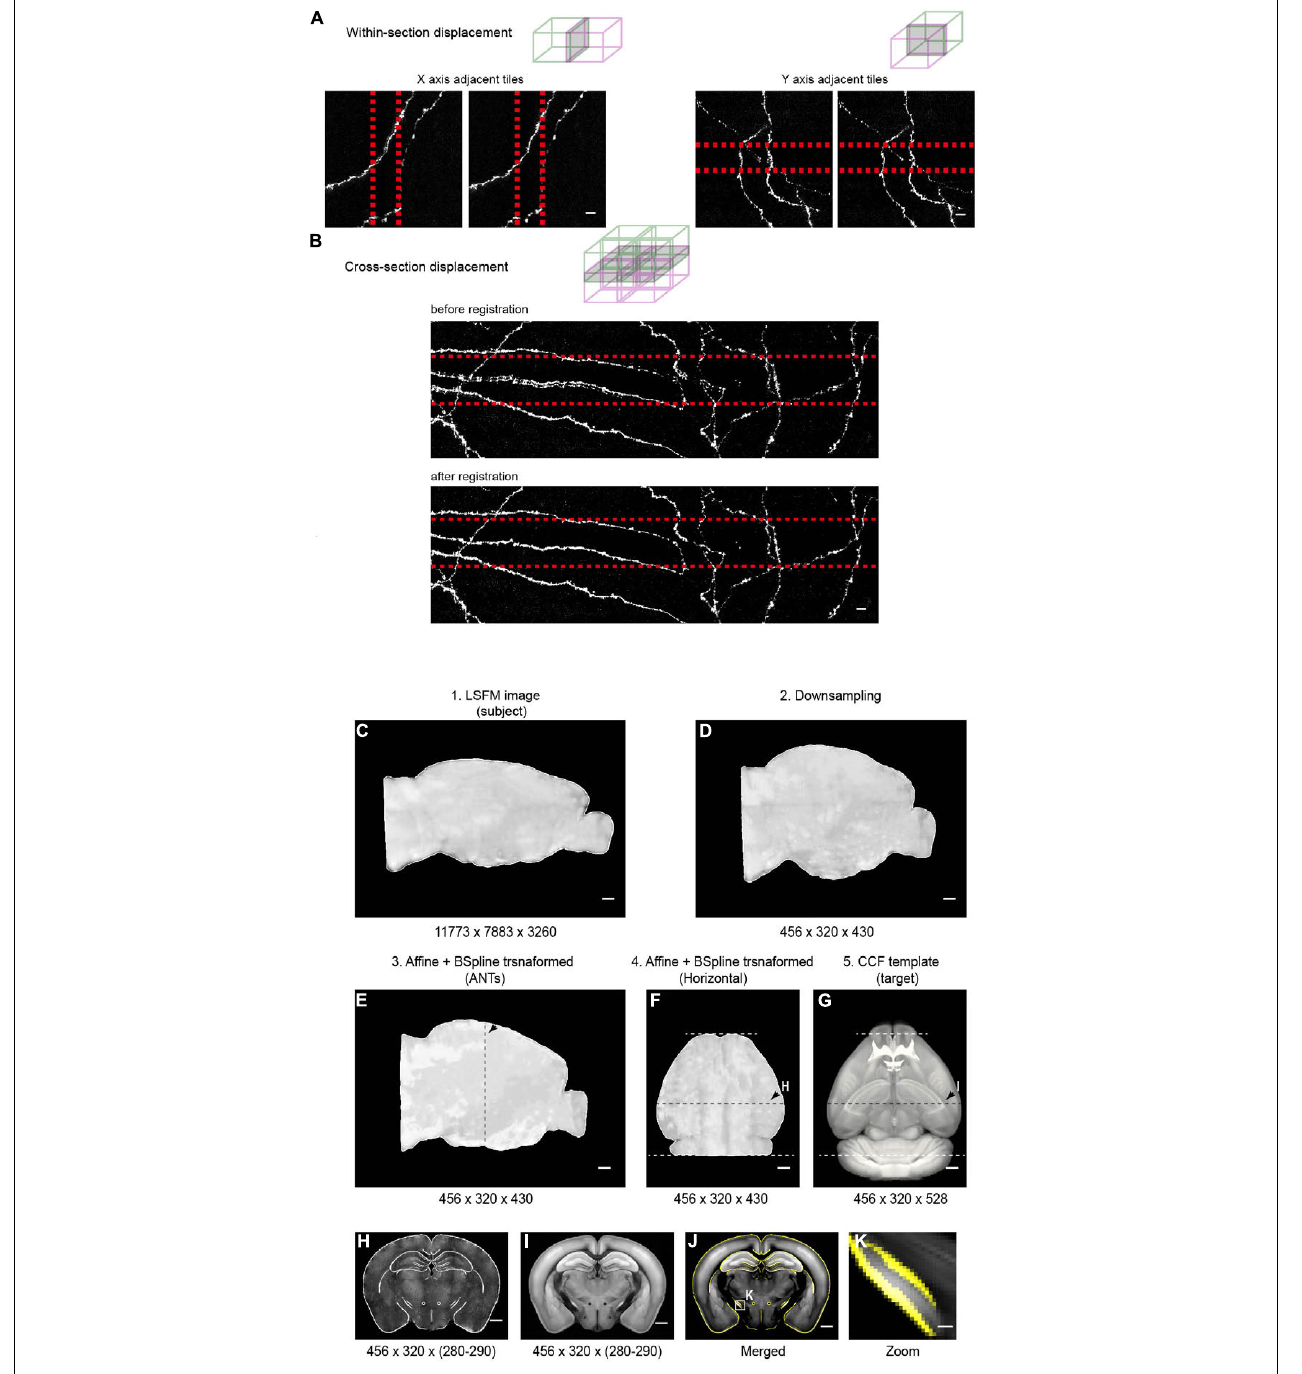
FIGURE 11 | Stitching and registration pipeline. (A) In-plane adjacent tiles are stitched by applying a small rigid shift (typically ∼ 10 pixels between adjacent tiles). Left: MIP of adjacent tiles (along the X axis) before (left) and after (right) stitching. Right: MIP of adjacent tiles (along the Y axis) before (left) and after (right) stitching. Overlapped regions are indicated by red-dotted lines. (B) Stitching along the Z axis. Top: MIP of an example region (2 × 2 × 2 tiles) before (top) and after (bottom) non-rigid stitching. Before stitching, there were clear mismatches that were corrected after stitching. (C–E) Pipeline of registration of whole-brain imaging data to the Common Coordinate Framework (CCF v3) for CUBIC-X-cleared brains. The whole brain 3D volume (C) is down-sampled to 25 µ m × 25 µ m × 25 µ m voxels (D) , the same voxel size as the Allen Reference Brain. Then affine transformation is applied in the software ANTs to register the down-sampled brain to the Allen Reference Brain (E) . Arrows in E–G indicate the position of the example coronal section shown in H–I . (F,G) Horizontal view of the registered brain and the corresponding reference brain. (H,I) Coronal slice at the position indicated by arrows in (F,G) . (J) Overlay of the boundaries of registered brain (yellow) on the Allen Reference Brain. (K) Enlarged view of the boxed region in (J) shows nice match between the registered brain and the reference brain. Scale bars, 5 µ m (A,B) , 1 mm (C–J) , 100 µ m (K) .